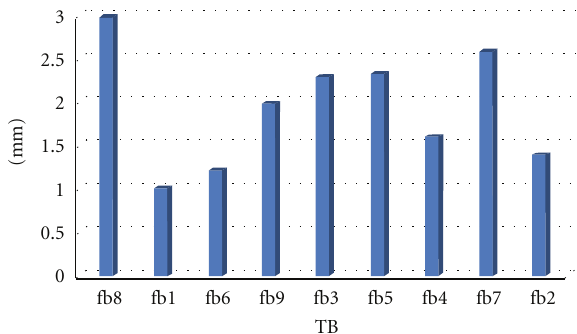
Mean measured pullback after a 2-1 pullback: 0.956 mm ± 0.378 mm SD/Known contact distance: 1mm Mean measured pull back after a 3–1 pullback: